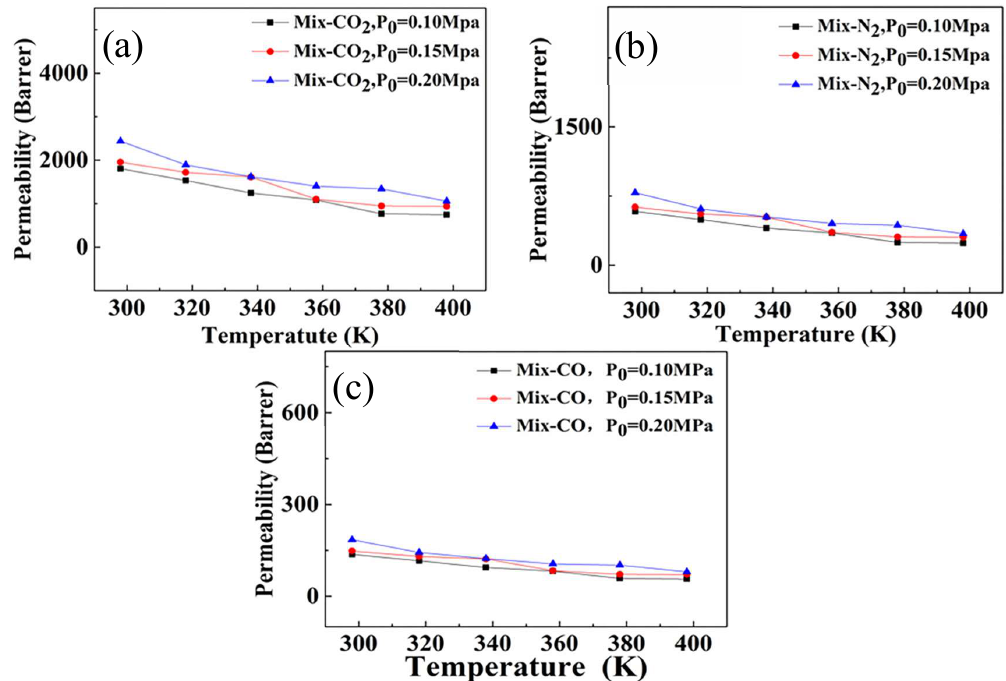
Figure 10. Gas separation performance of Pebax/GO/SWCNTs for mix gas (N 2 60%, CO 2 20%, N 2 20%), ( a ) CO 2 , ( b ) N 2 , ( c ) CO.